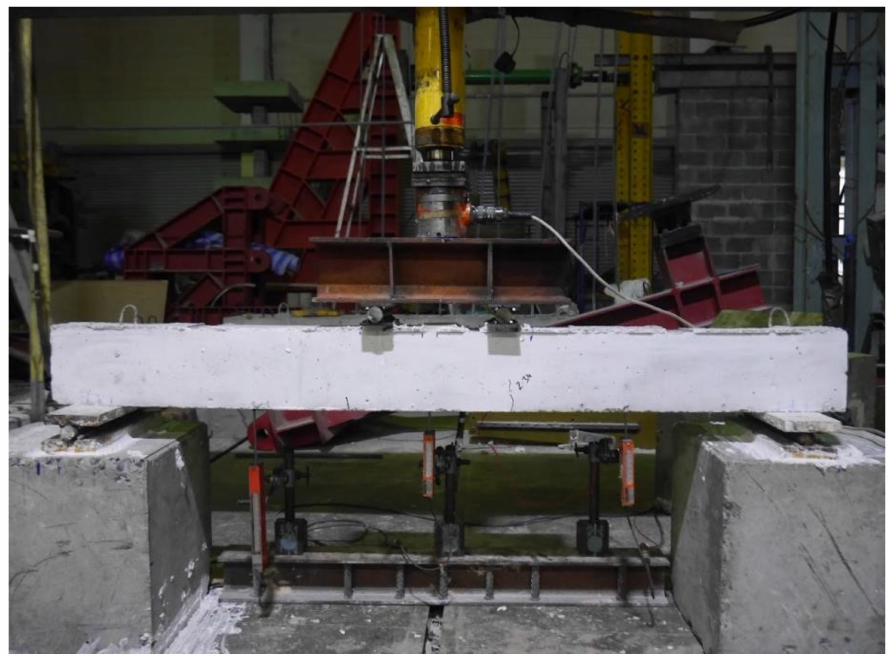
Figure 11. Laboratory test